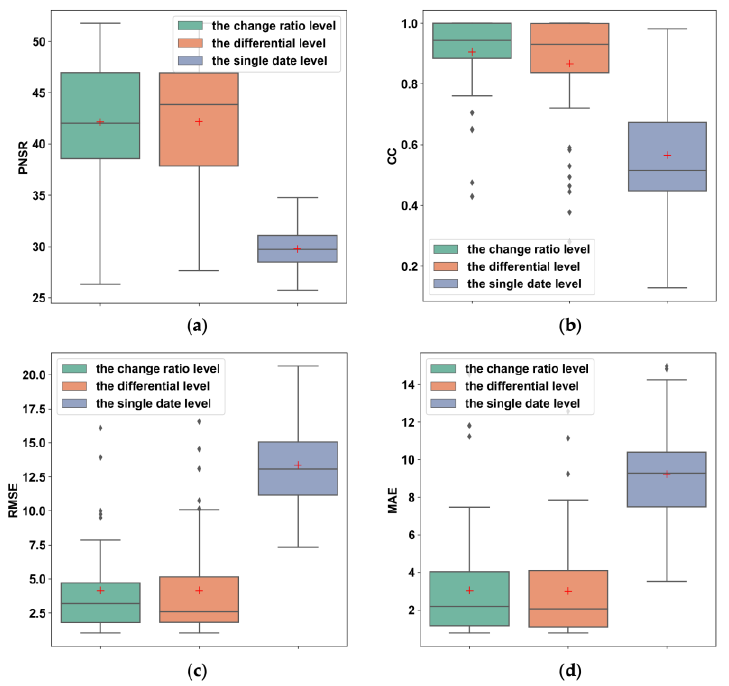
Figure 6. Comparison of model fusion results based on unmixing on the single date level, the differential level, and the change ratio level. ( a ) PNSR; ( b ) CC; ( c ) RMSE; ( d ) MAE.